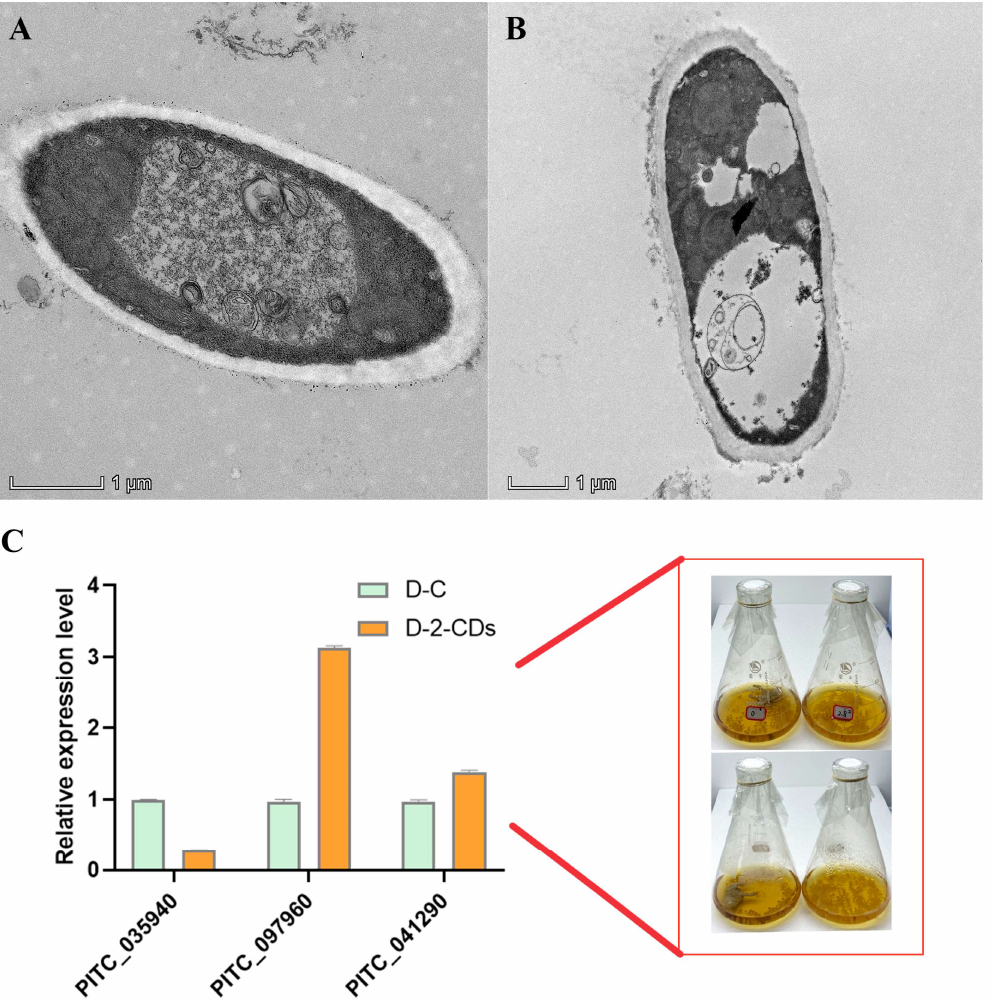
Figure 8. TEM images and RTq-PCR analysis for P. italicum . TEM observation: ( A ) D − C, ( B ) D − 2 − CDs; ( C ) relative expression level between D − C and D − 2 − CDs; D − C: P. italicum with no 2 − CDs treatment (96 h); D − 2 − CDs: P. italicum treated with 2.8 µ g/mL 2 − CDs (48 h for routine culture and 48 h for 2 − CDs treatment).